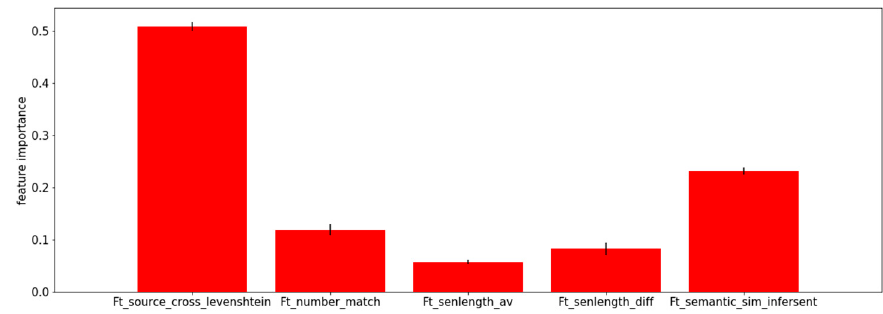
Figure 4. Feature importance (impurity) of our features in the training set. Black vertical lines show the variance of the feature importance.